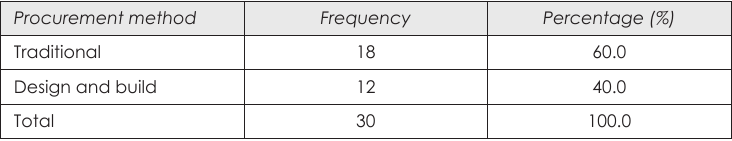
Table 2: Procurement method used for building